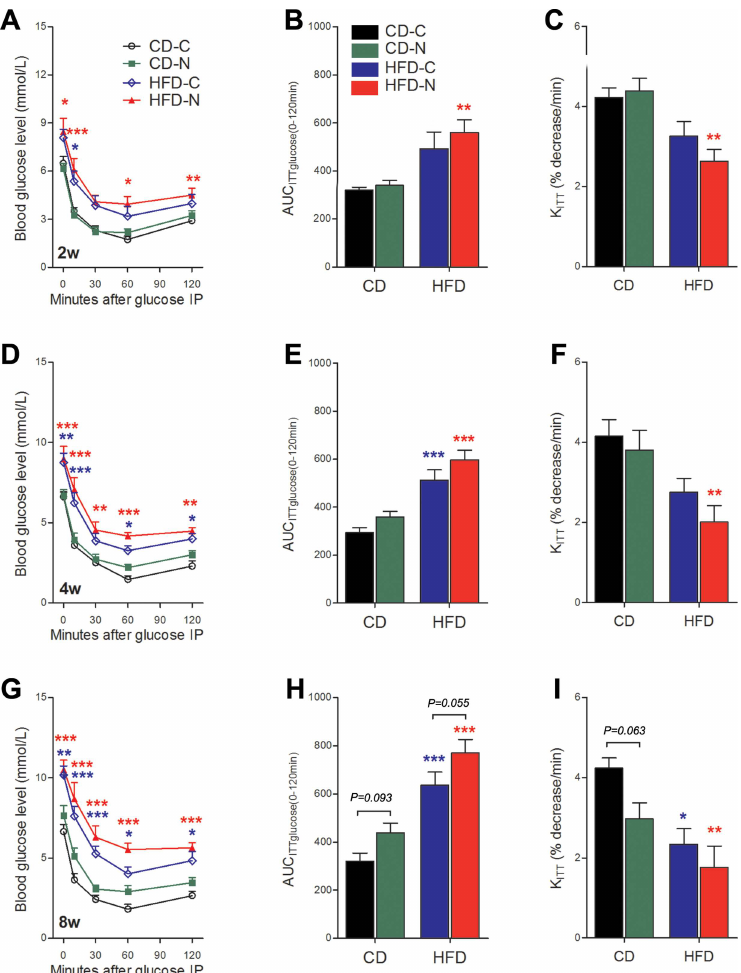
Fig 2. Effect of noise exposure on systemic insulin sensitivity in mice. (A, D, G) The IPITT blood glucose levels of 4 h-fasted mice performed after 2 weeks (A), 4weeks (D) and 8weeks (G) of treatment. (B, E, H) The corresponding results of A (B), D (E) and G (H) analyzed by area under the curve, i.e., AUC ITTglucose . (C, F, I) The plasma glucose disappearance rate ( K ITT ) derived from IPITT corresponding to A (C), D (F) and G (I). The values are presented as means ± SEM of 8 mice per group. The differently-colored asterisks relate to comparisons between the color-matched group and the CD-C group determined using Bonferroni’s post hoc test following a repeated two-way ANOVA (A, D, G) or Tukey’s post hoc test following a one-way ANOVA (all other panels). The number of asterisks indicates the level of significance: (cid:3) p < 0.05, (cid:3)(cid:3) p < 0.01 and (cid:3)(cid:3)(cid:3) p <